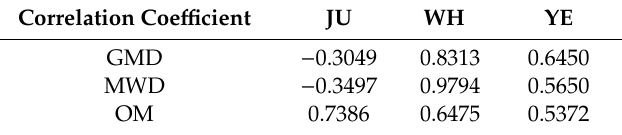
Figure 10. Saturated water conductivity ( K s ) in the WH, YE, and JU profiles. Table 2. The correlation between K s values and GMD , MWD , and OM contents of the plinthosol samples. Correlation Coefficient